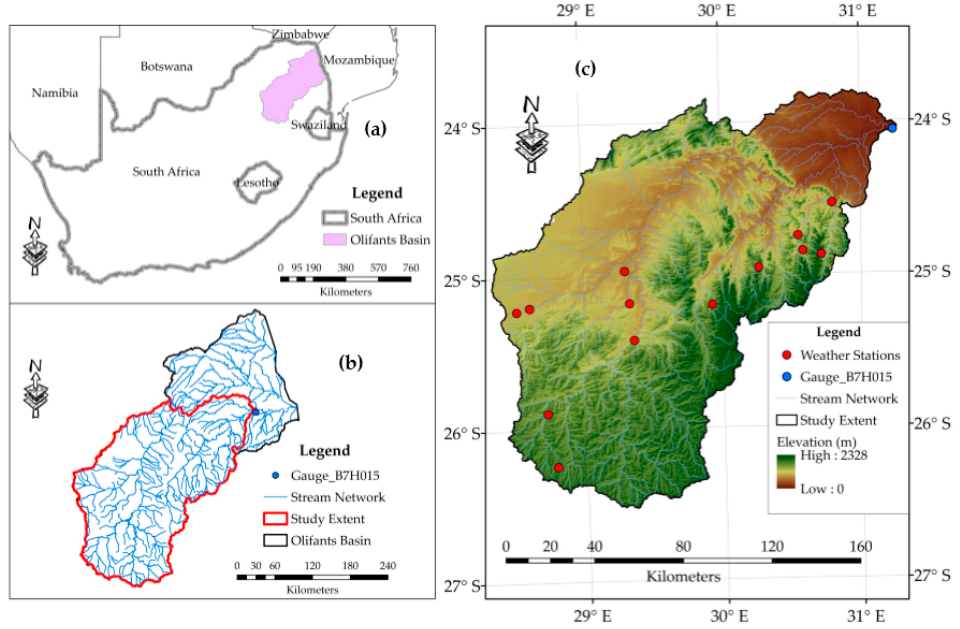
Figure 1. Study area within the context of South Africa ( a ), study extent ( b ) and weather stations ( c ).